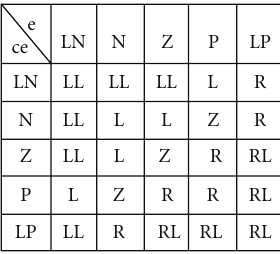
Figure 14: Surface control for a tuning factor k = 0 . 5.